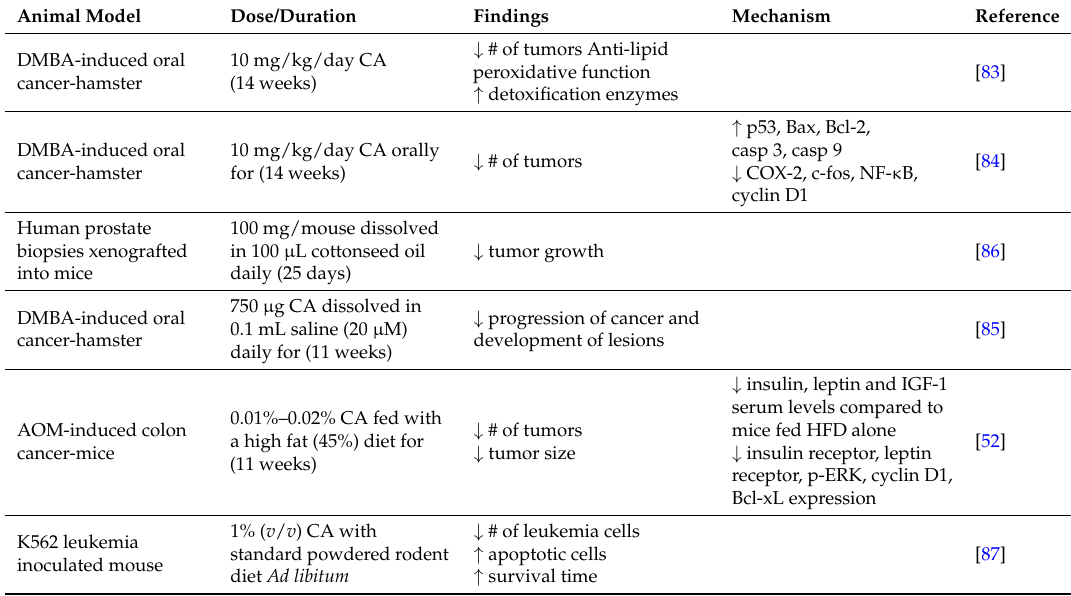
Table 12. Anticancer effects of Carnosic Acid (CA). In vivo